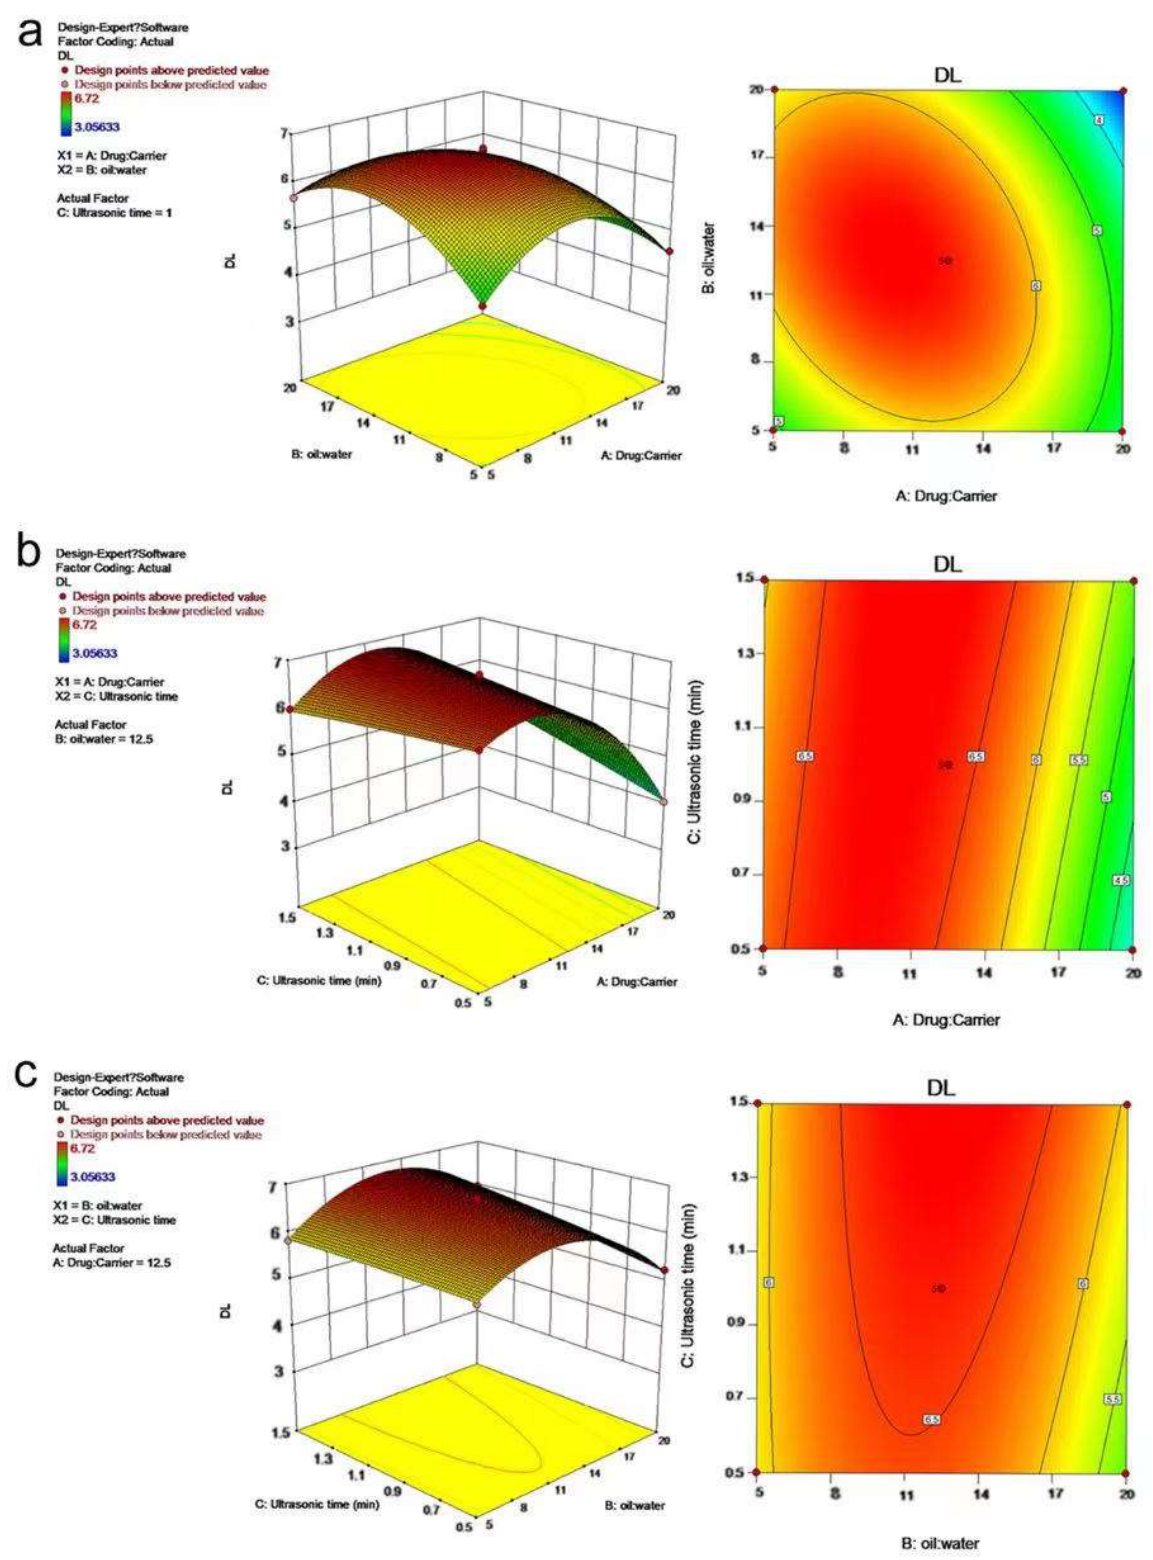
Figure 4. Effects of various factors on DL in AST@PLGA nanoparticles. ( a ) 3D response surface maps and contour map of drug − carrier ratio and oil − water ratio. ( b ) 3D response surface maps and contour map of drug − carrier ratio and ultrasonic time. ( c ) 3D response surface maps and contour map of oil − water ratio and ultrasonic time.